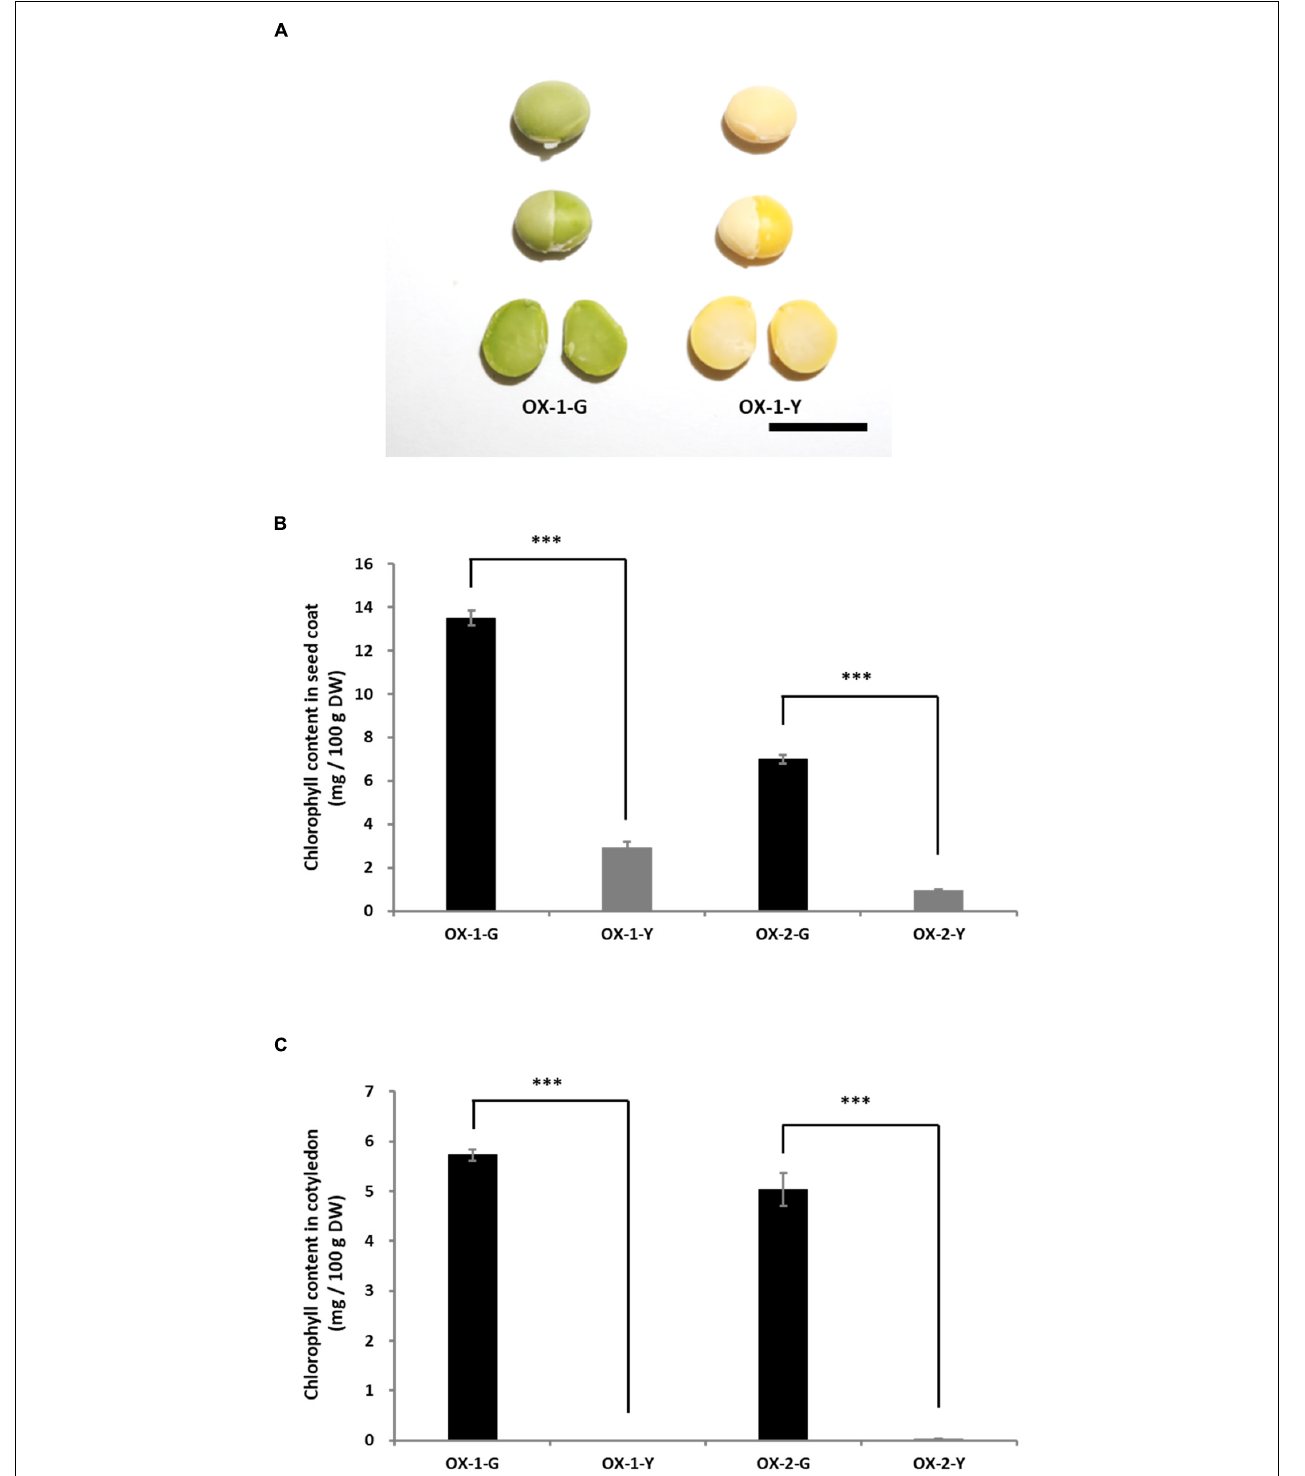
FIGURE 6 | Characterization of transgenic plants overexpressing G . (A) Appearances of seed and cotyledons of transgenic lines. OX-1-G and OX-2-G indicate green seed coat lines. OX-1-Y and OX-2-Y indicate yellow seed coat lines. In the T 1 progeny, the green and yellow seed coat traits are genetically segregated. Scale bar = 1 cm. The chlorophyll content in the seed coat (B) and cotyledons (C) . Significant differences were observed in the chlorophyll content of seed coats and cotyledons between -G and -Y lines. ∗∗∗ indicates significant differences at the 0.1% level.